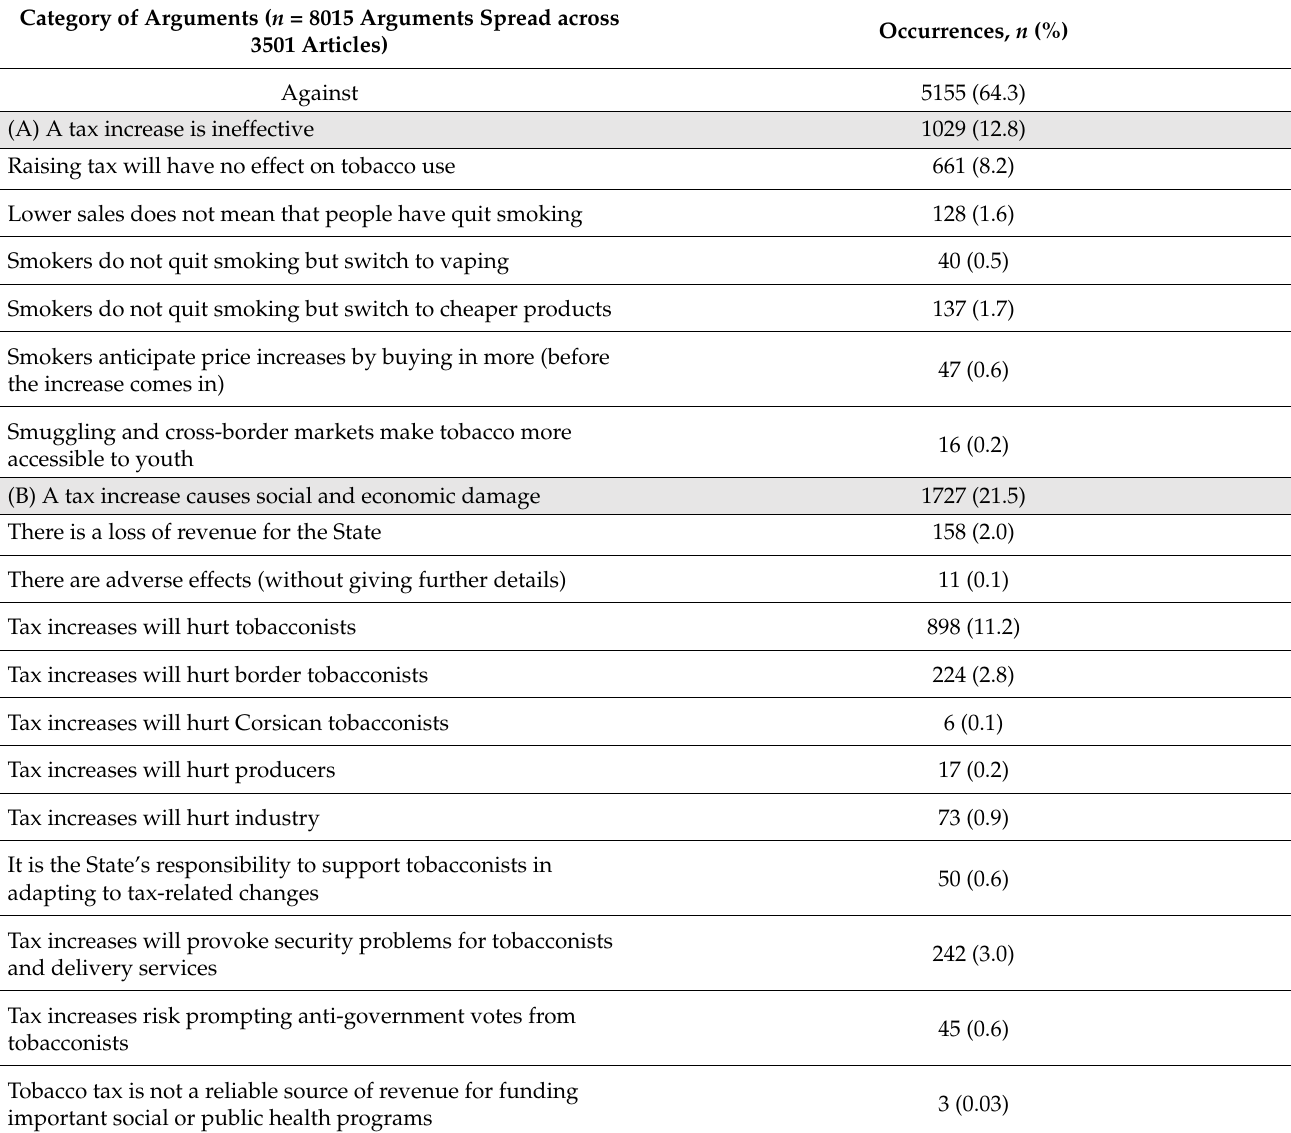
Table 2. Arguments against tobacco tax